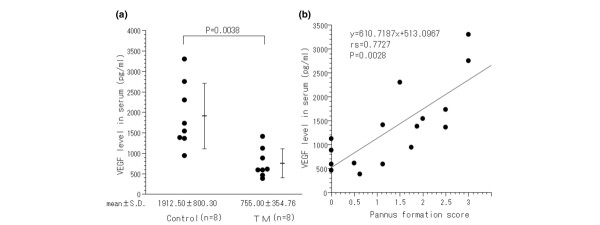
VEGF levels in the serum are correlated with the extent of arthritis in rats. (a) VEGF levels in the serum are higher in control rats than in tetrathiomolybdate (TM)-treated rats (* P < 0.01). VEGF was analyzed by ELISA, as described in Materials and methods. Data represent the mean ± standard deviation. (b) A significant positive relationship between VEGF levels in the serum and the severity of pannus formation in hindlimbs of adjuvant-induced arthritis rats, which includes both the control group and the TM-treated group. VEGF, vascular endothelial growth factor.